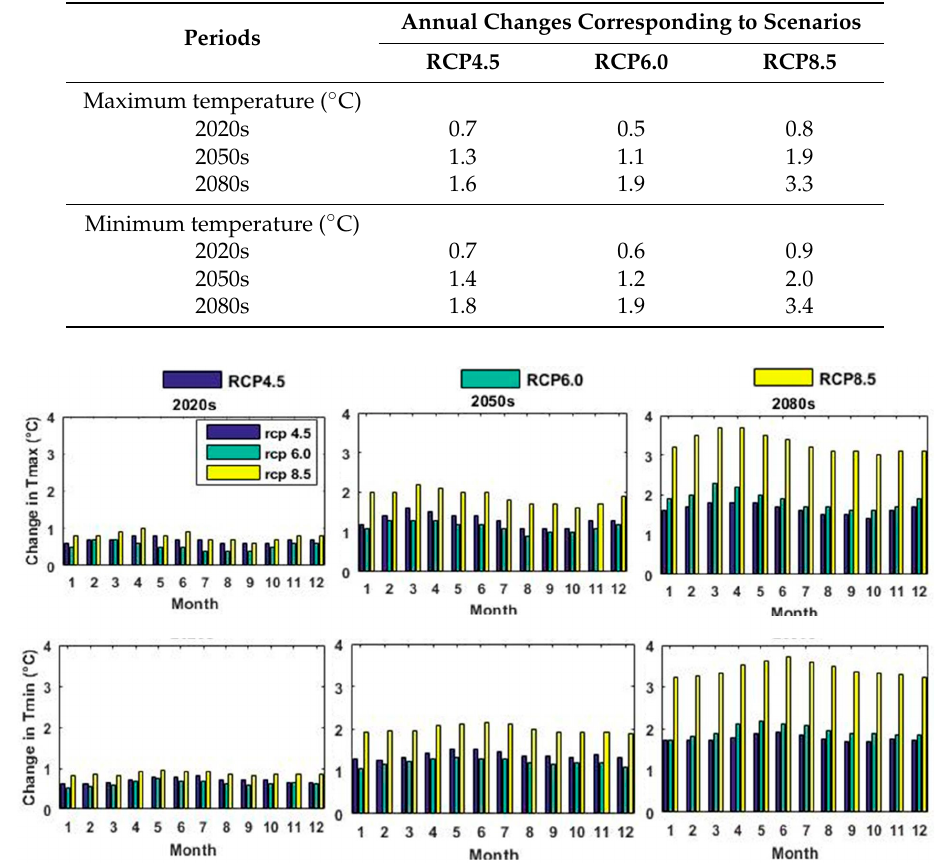
Figure 9. Mean monthly changes in temperatures (t max and t min (°C) for the future years (2020s, 2050s and 2080s)) under the RCP4.5, 6.0 and 8.5 scenarios.